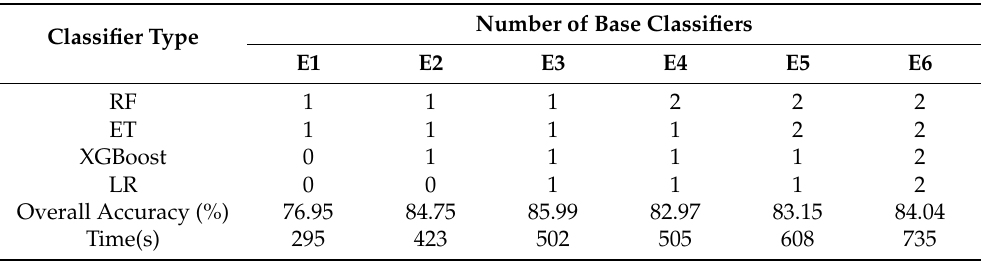
Table 4. Overall accuracy and time consumption using different number of base classifiers. E1–E6 represent the codes of the experimental